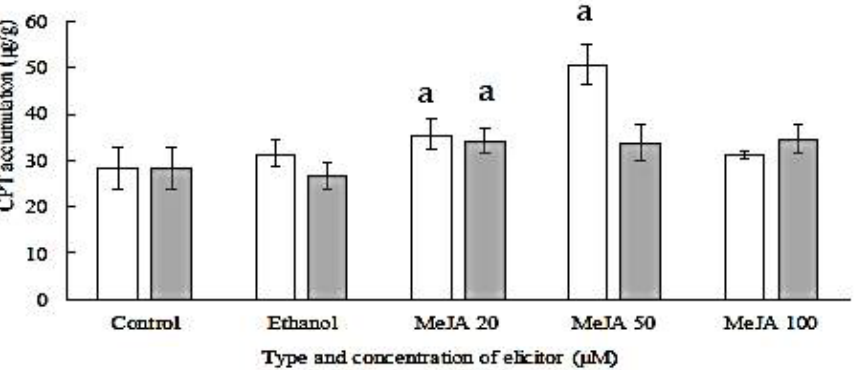
Figure 4. Effects of MeJA elicitation on CPT concentration in roots by elicitation with ethanol and MeJA (20, 50 and 100 µM) for 12 h (□) and 24 h ( ■ ) before harvesting. The values are expressed as mean ± SD ( n = 3); a: significant at p < 0.05 vs. control.